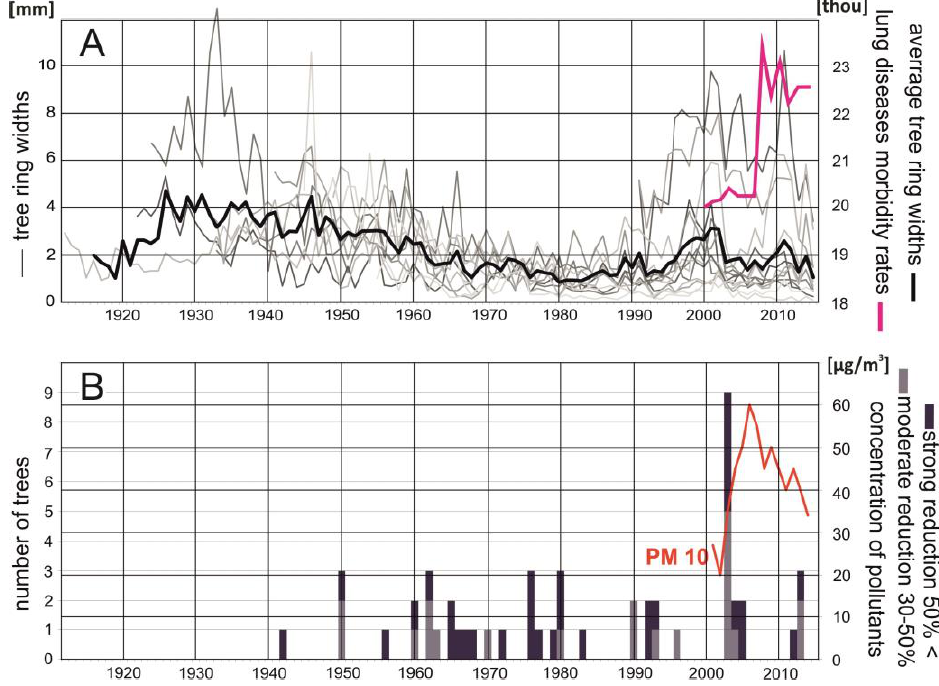
Fig. 2. Dendrochronological data for the Rabka-Zdrój study site: tree-ring widths (A) and number of trees showing the beginnings of ring reductions (B) compared to lung diseases morbidity rates and air pollution level in Rabka-Zdrój